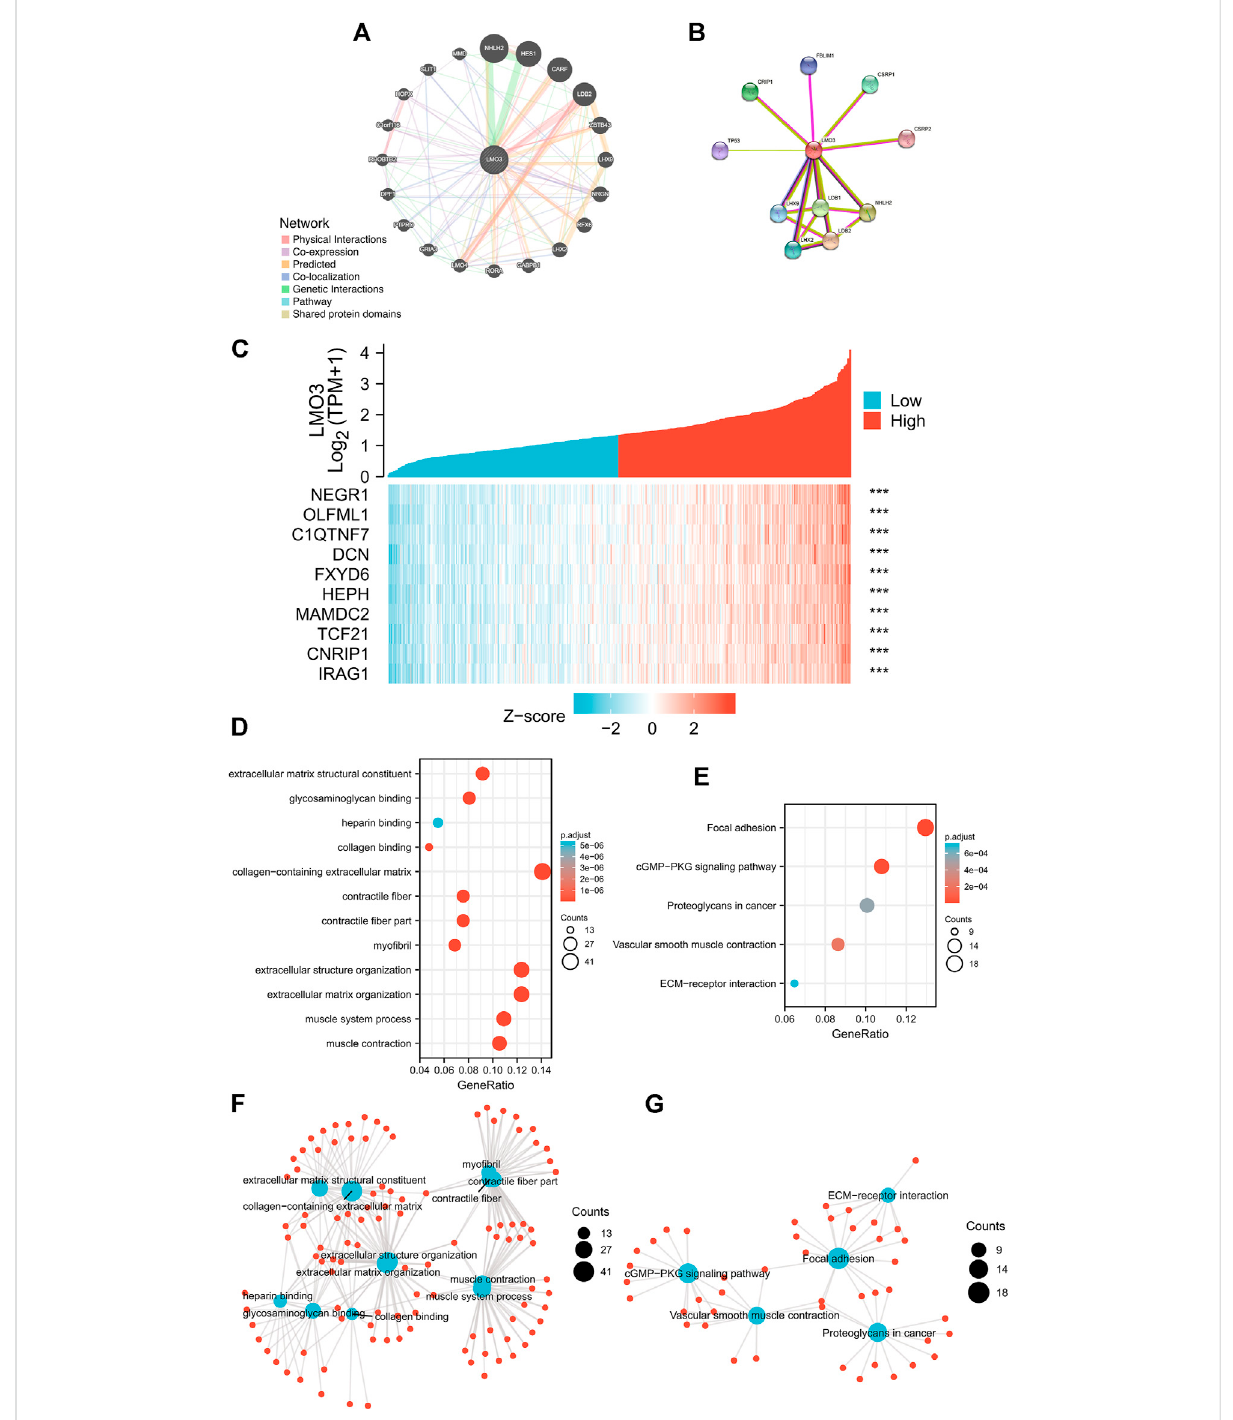
FIGURE 4 (A) Gene – gene interaction network of LMO3 was constructed using GeneMANIA. (B) PPI network of LMO3 was generated using STRING. (C) Top 10 genes correlated with LMO3 in PRAD. (D) and (F) show top 20 enrichment terms in GO. (E) and (G) show top 20 KEGG enrichment pathways. * p < 0.05, ** p < 0.01, and *** p <